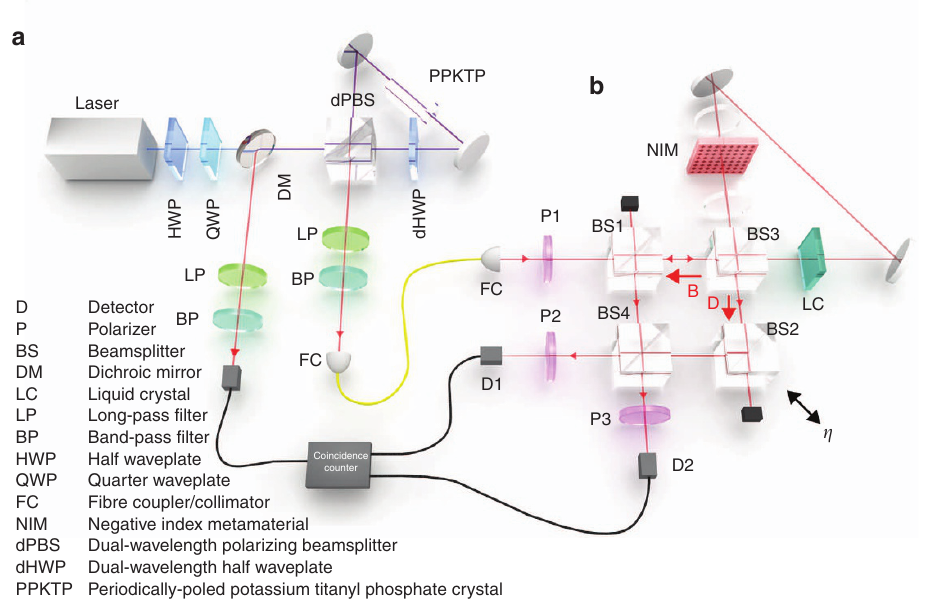
Figure 2 | Experimental apparatus. A detailed schematic of experiment to search for a quaternionic contribution to phase shifts. ( a ) We generate photon pairs in a separable polarization state. One photon is used to herald while the other one is sent to our interferometers. ( b ) We couple a Sagnac interferometer into a Mach–Zehnder interferometer to search for non-commuting phases. We monitor the interference in the Mach–Zehnder interferometer as its phase Z is scanned. The output photons are detected using single-photon detectors D1 and D2. The detectors are connected to coincidence logic to herald single photons. Two phases are applied inside the Sagnac which we can controllably ‘turn on’ and ‘turn off’. The liquid crystal (LC) is controlled by applying voltage to it, and the negative index metamaterial (NIM) is mounted on a motorized translation stage so it can be ‘turned off’ by physically removing it from the